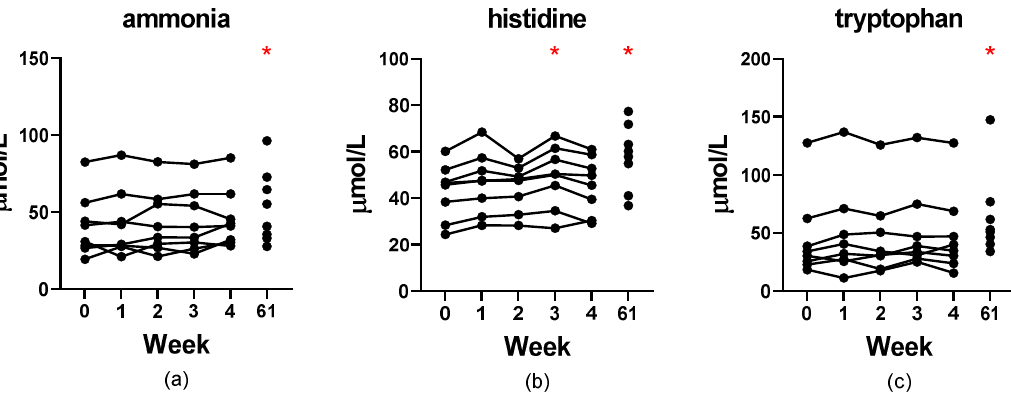
Figure 1. Stability of serum concentrations ( µ M) of ammonia ( a ), histidine ( b ), and tryptophan ( c ) in naïve serum stored at − 80 ◦ C for up to 4 weeks and deproteinized serum stored for 61 weeks. Red asterisks indicate significance ( p < 0.05) compared to week 0.